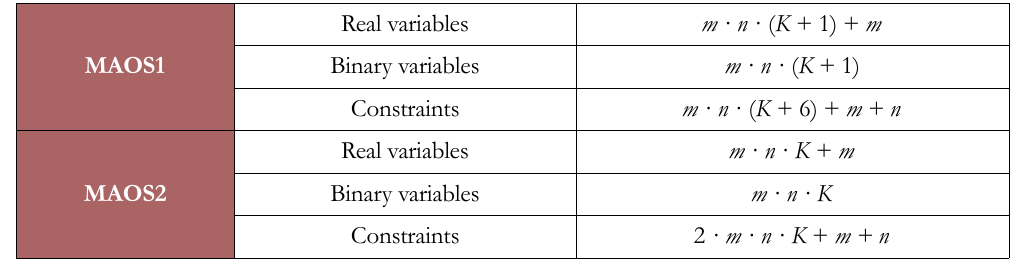
Table 1. Size of the